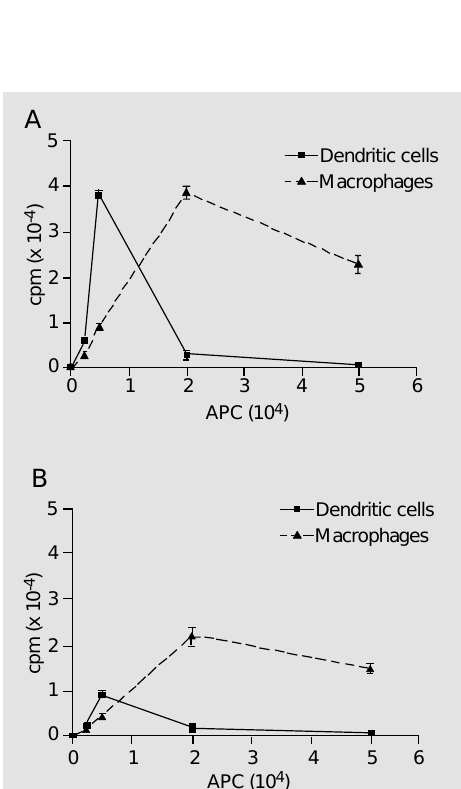
Figure 1 - Proliferation of im- mune T cells from A/Sn and B10.A mice stimulated with gp43 (10 µg/ml) in the presence of increasing concentrations of syngeneic dendritic cells. The [ 3 H]-thymidine incorporation by T cells plus different antigen-pre- senting cells (APC) in the ab- sence of gp43 was as follows: A/ Sn T cells, 1,500 ± 95, and B10.A, 1,300 ± 110. Results are representative of three inde- pendent experiments and are re- ported as arithmetic means ± SD. Figure 2 - Lymphokine profiles of T cells from A/Sn or B10.A mice stimulated with gp43 (10 µg/ml) in the presence of syngeneic dendritic cells. Culture superna- tants were assayed by ELISA for the presence of IL-2, IFN- g , IL-4 and IL-10. The levels of cytokines in the absence of gp43 were: A/ Sn (IL-2: 5 U/ml, IFN- g : 6.5 U/ml) and B10.A (IL-2: 4 U/ml, IFN- g : 5.5 U/ml). Results are represen- tative of three independent ex- periments.